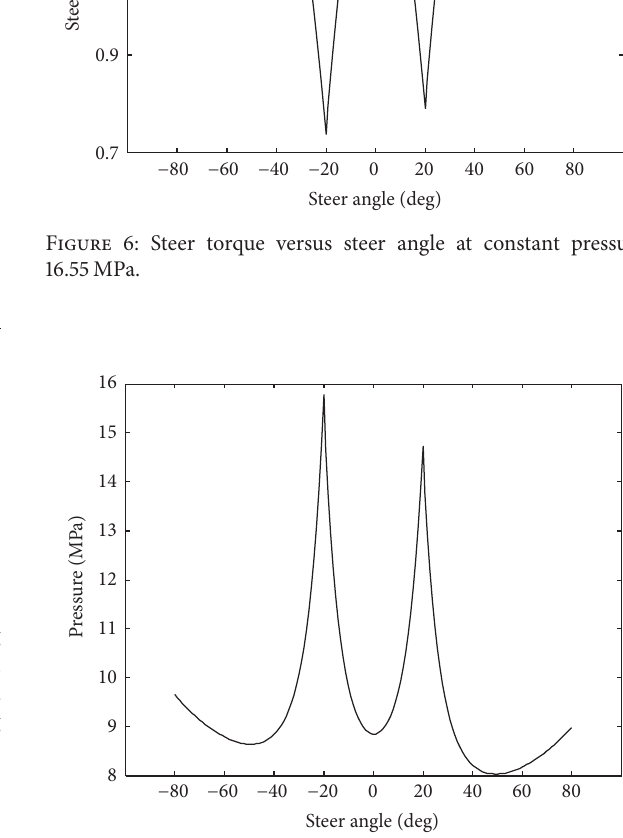
Figure 7: Request pressure at the constant torque 7000